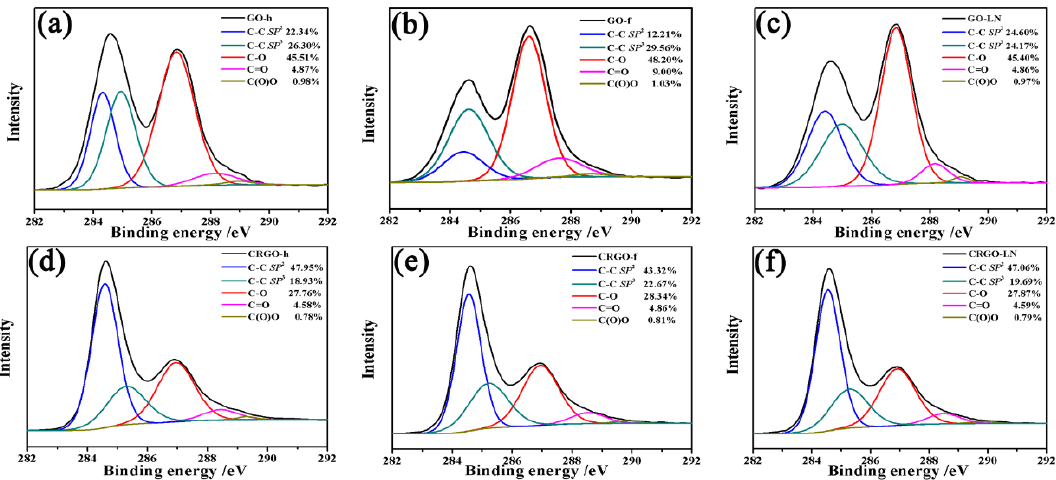
Figure 2. High-resolution deconvoluted C 1 s XPS spectra of ( a ) GO-h; ( b ) GO-f; ( c ) GO-LN; ( d ) CRGO-h; ( e ) CRGO-f; and ( f ) CRGO-LN films.